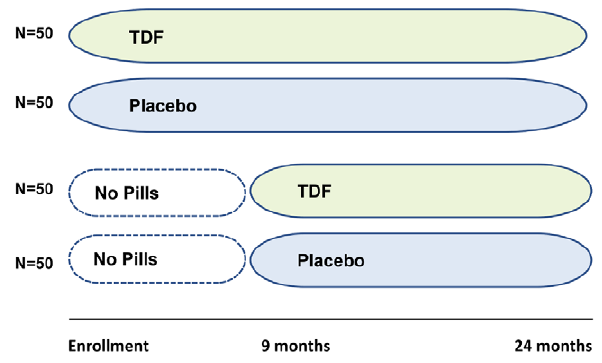
Figure 2. Study design. Participants were randomly assigned to one of four arms. Participants in the 2 immediate arms (TDF vs. placebo) initiated study drug at enrollment; those in the 2 delayed arms (TDF vs. placebo) initiated study drug at the 9 month visit. TDF, tenofovir disoproxil fumarate.